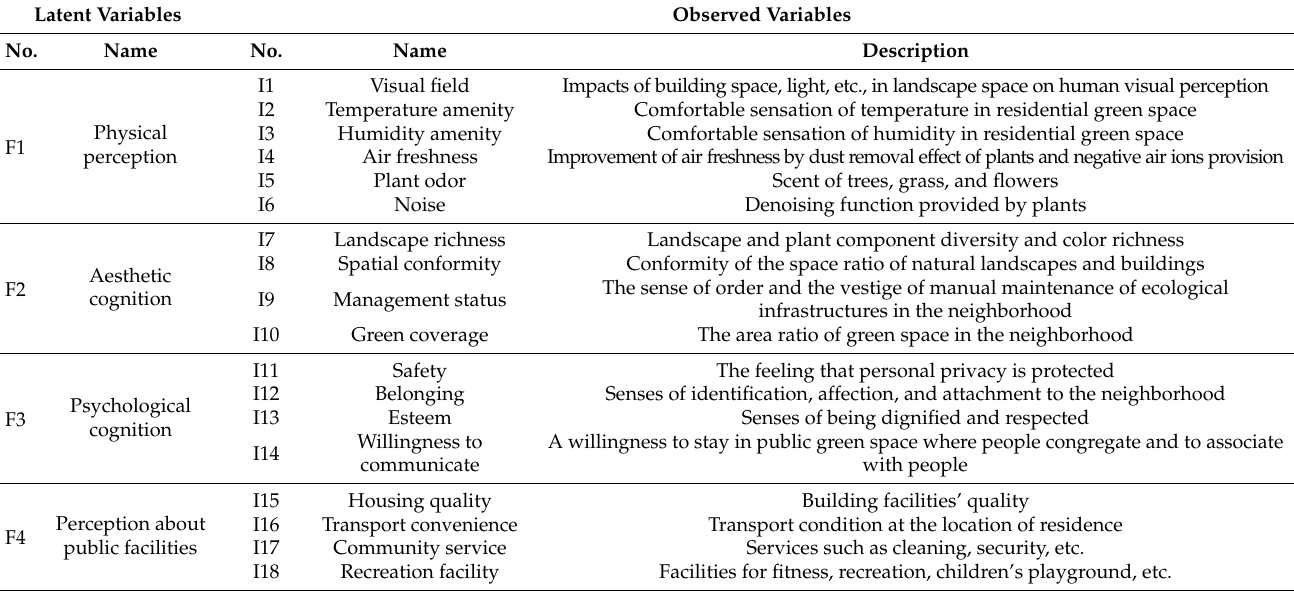
Table 2. Latent variables and observed variables of